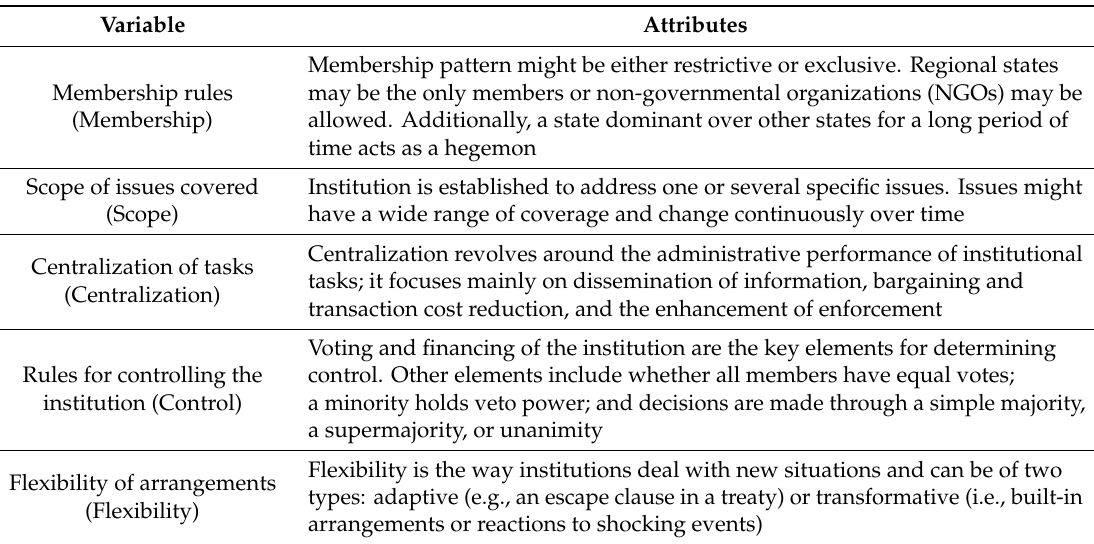
Table 1. Five key measurable dimensions of an institution / regime adapted from